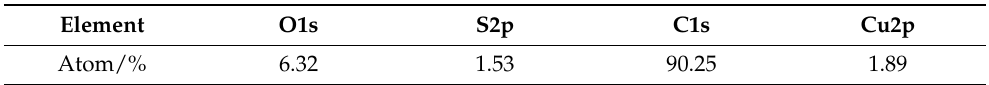
Figure 6. XPS energy spectrum of the contact surface in the air after 120 min sliding at the speed of 119 mm/s. ( a ) Overall test results, ( b ) Cu peak spectrum. Table 3. Chemical valence and atomic percentage of peak elements in the air at the sliding speed of 119 mm/s.